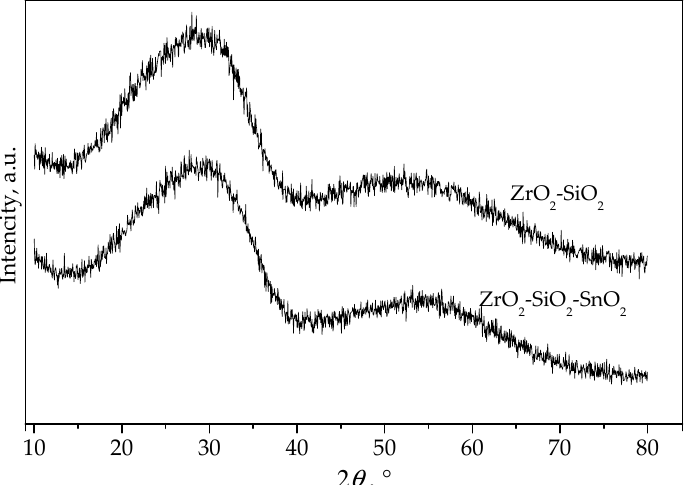
Figure 1. X-ray diffraction patterns of the ZrO 2 –SiO 2 and ZrO 2 –SiO 2 –SnO 2 samples after calcination at 750 C for 2 h.